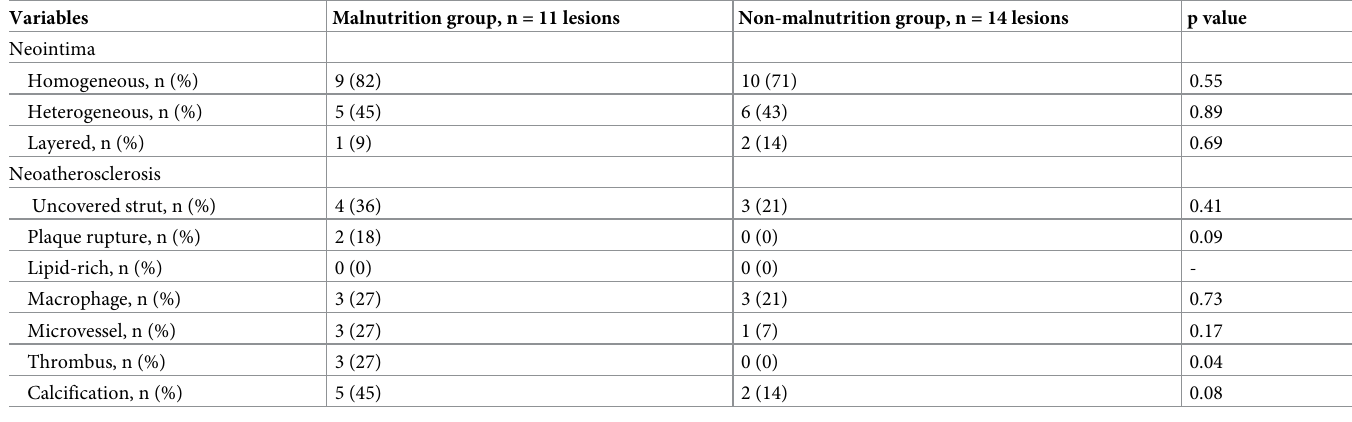
group, whereas calcified plaques tended to be larger in the malnutrition group, but no signifi- cant difference was observed. Only the angle of calcified nodule at 6-months was significantly greater in the malnutrition group. Intergroup comparisons of the amount of plaque change showed significant differences in lipid plaque length [0 (-2.2 − 0) vs. 0 (-0.4 − 2.3), p = 0.03] and calcified plaque angle [14.4 (10.4 − 24.5) vs. 4.9 (-0.9 − 19.4), p < 0.01]. The median change in the calcified plaque angle was 10.7˚; therefore, a change of > 10˚ after 6 months was defined as significant plaque progression. In the univariate nominal logistic analysis to examine the influ- encing factors, "malnutrition as assessed by GNRI" [odds ratio (OR): 8.17; 95% confidence interval (CI): 1.79 to 37.33; p < 0.01] and “serum phosphorus level” (OR: 3.73; 95% CI: 1.42 to 9.81; p < 0.01) were significantly related to each other. Next, we performed a multivariate nominal logistic analysis with other factors known to influence calcified plaques, including the two factors described above [14–17]. Both multivariate analysis of “malnutrition as assessed by GNRI” and “serum phosphorus level,” and multivariate analysis of other factors showed that these two factors were significantly related (Table 6). We performed the same analysis for "lipid plaque length." Since the median length was 0.7 mm, we performed a univariate nominal logistic analysis, defining the group with significant plaque progression as the group in which the difference in length between the 6-month and baseline values was greater than 0 mm. In the univariate analysis, malnutrition as assessed by GNRI, BMI, and arm circumference were Table 4. OCT findings of culprit lesions at 6-months